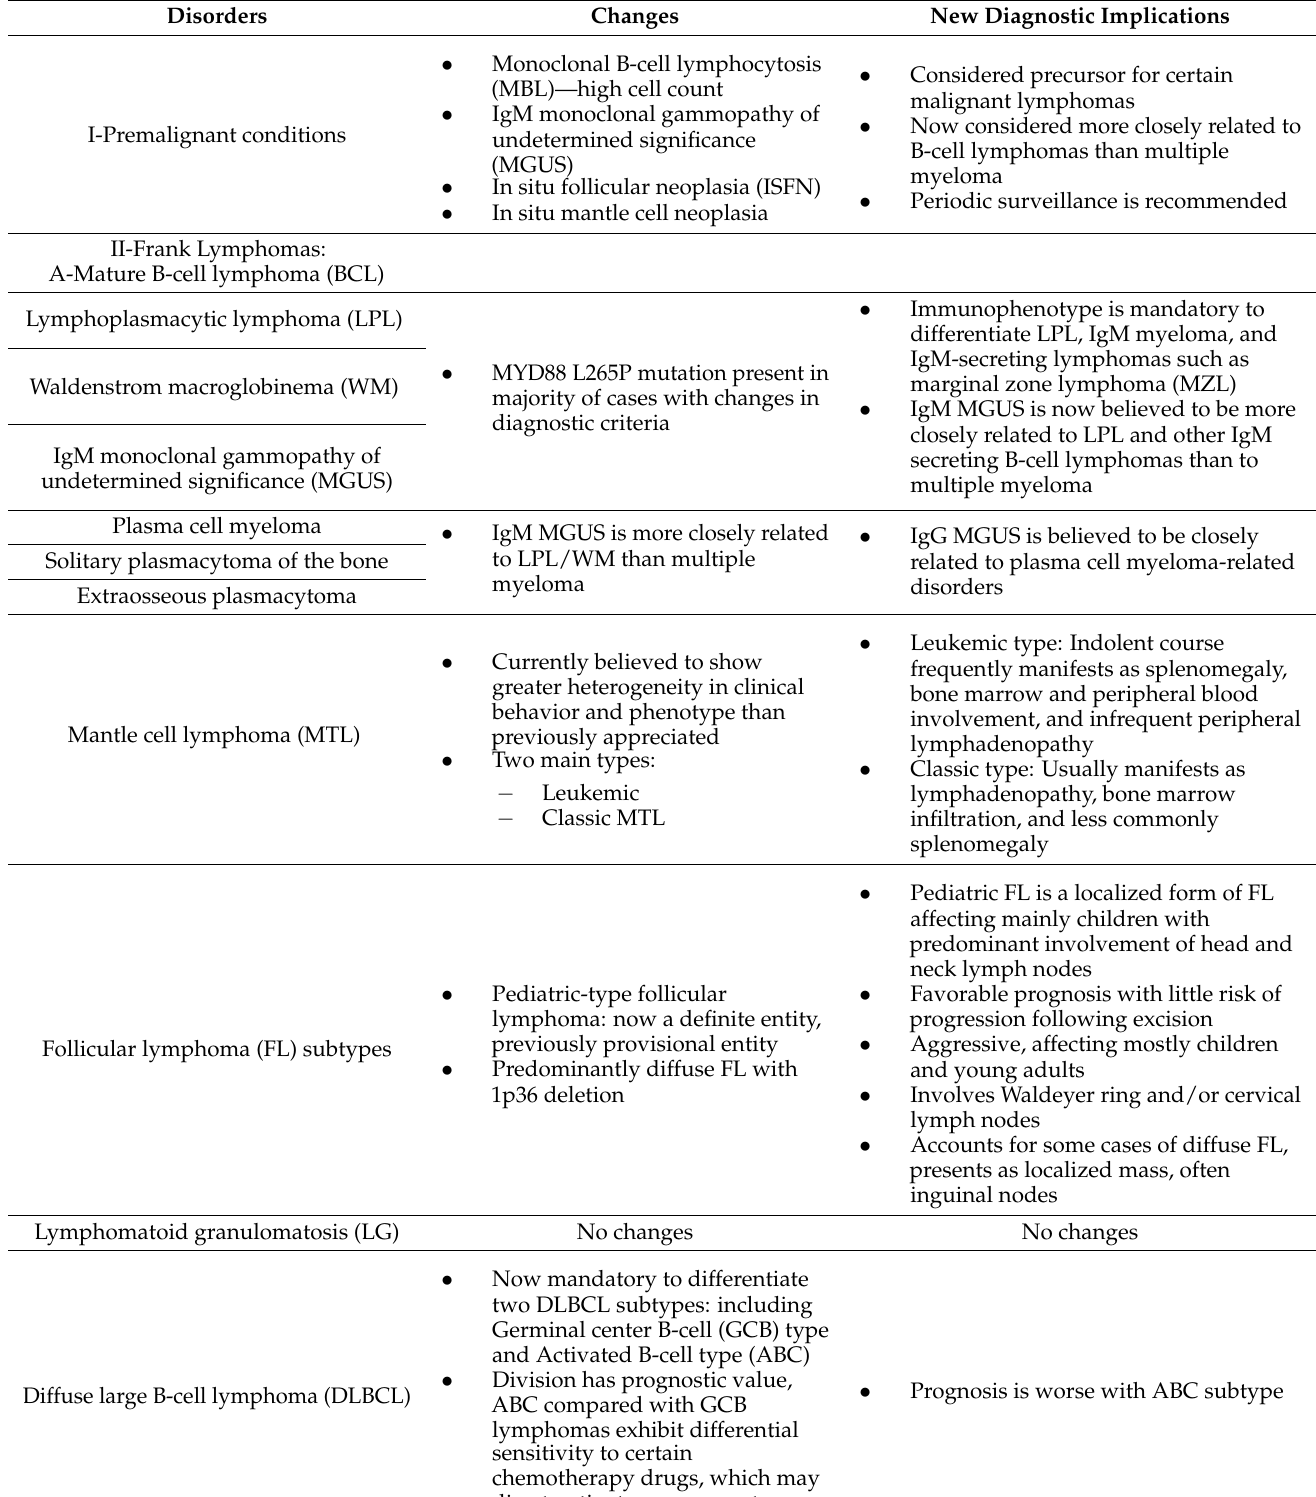
Table 1. Summary of changes contained in the updated 2016 WHO classification of B-cell LPD. New entities have been added, former entities have been recategorized, and some provisional entities have been